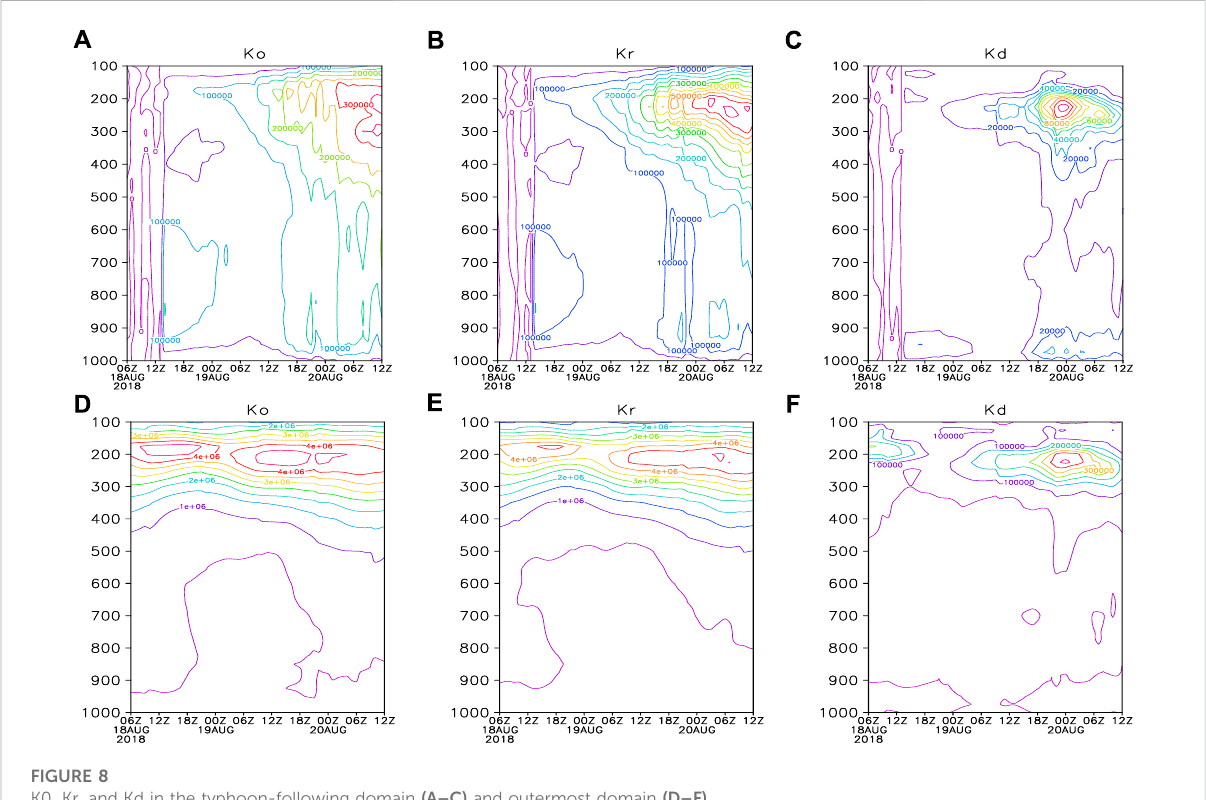
FIGURE 8 K0, Kr, and Kd in the typhoon-following domain (A – C) and outermost domain (D – F)